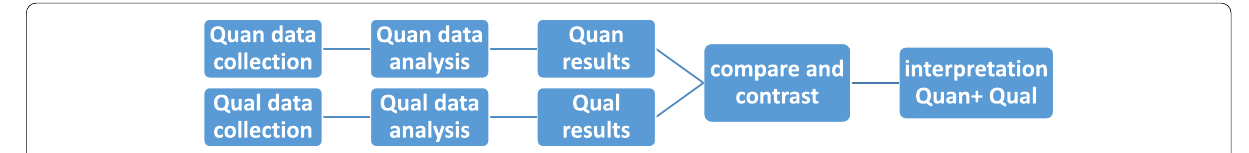
Fig. 1 Framework of mixed-methods research design used in the current